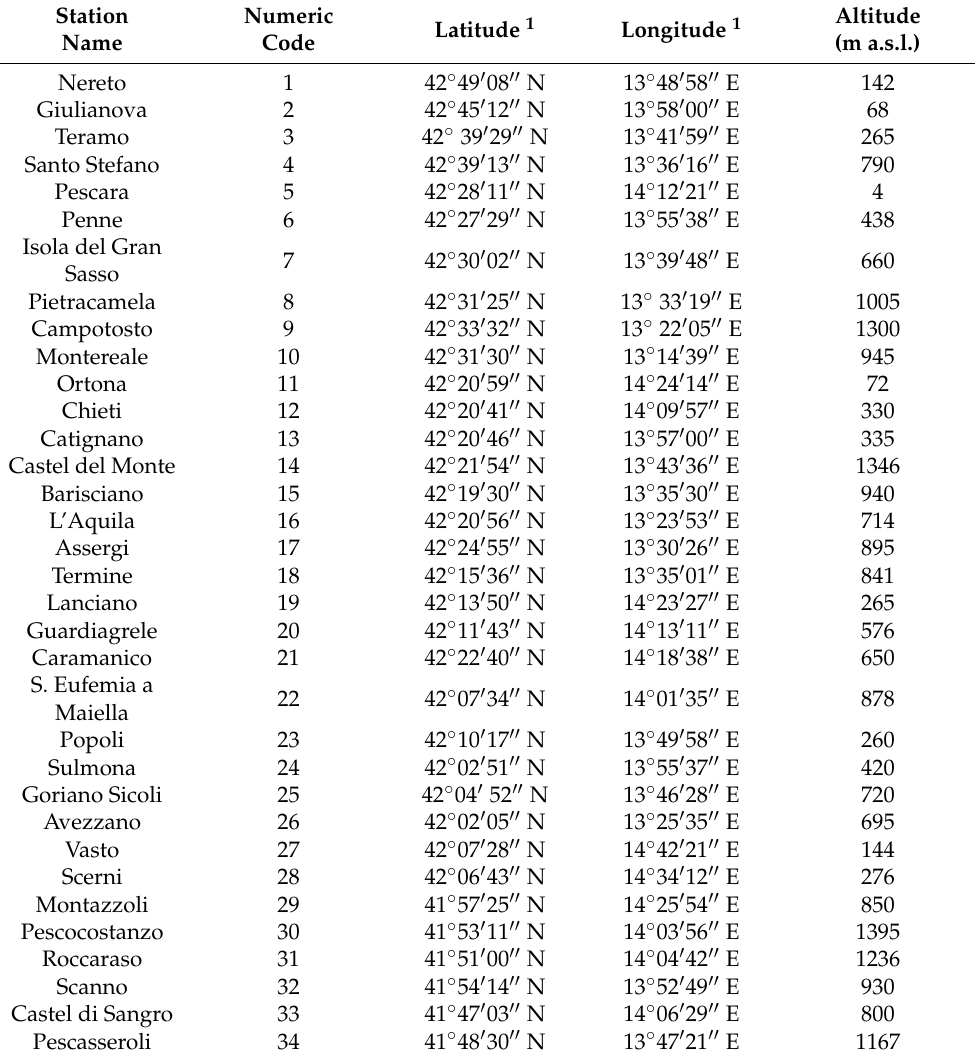
Table 1. Name of meteorological station, code number, geographical coordinates, and altitude of each